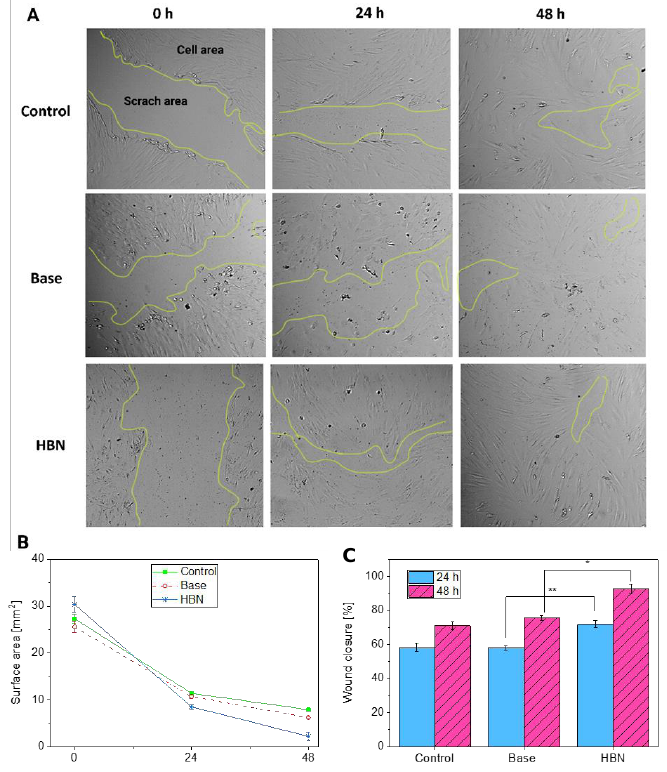
Figure 9. ( A ) Representative bright-field images show HDF cell migration after the scratch at time 0 and after 24 and 48 h of incubation with the HDF control cells and formulations. ( B ) The wound area expressed as the remaining area uncovered by the cells. The scratch area at time point 0 hours, and after 24 and 48 h of incubation with the formulations. ( C ) Wound closure expressed as the percentage of the closure of the scratched gap after 24 and 48 h of incubation with the formulations. All experiments were repeated 3 times in triplicate. The results are the means of three measurements. * , ** p -Value < 0.05 compared to the control. Clinical skin test was used to evaluate the contact allergy of the patches containing the herbal and base creams (Figure